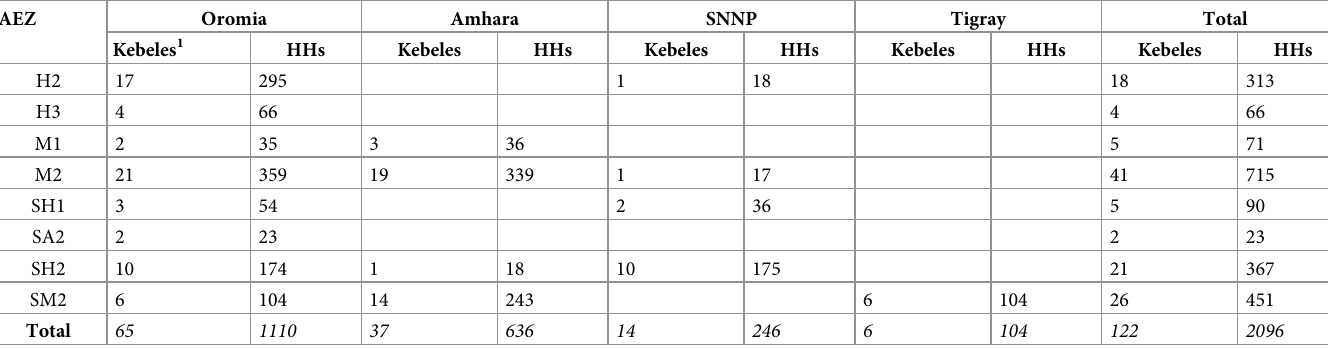
Table 1. Sample Kebeles and households (HHs) by agro-ecological zone (AEZ) and region, Ethiopia (original 2009/10 sample).